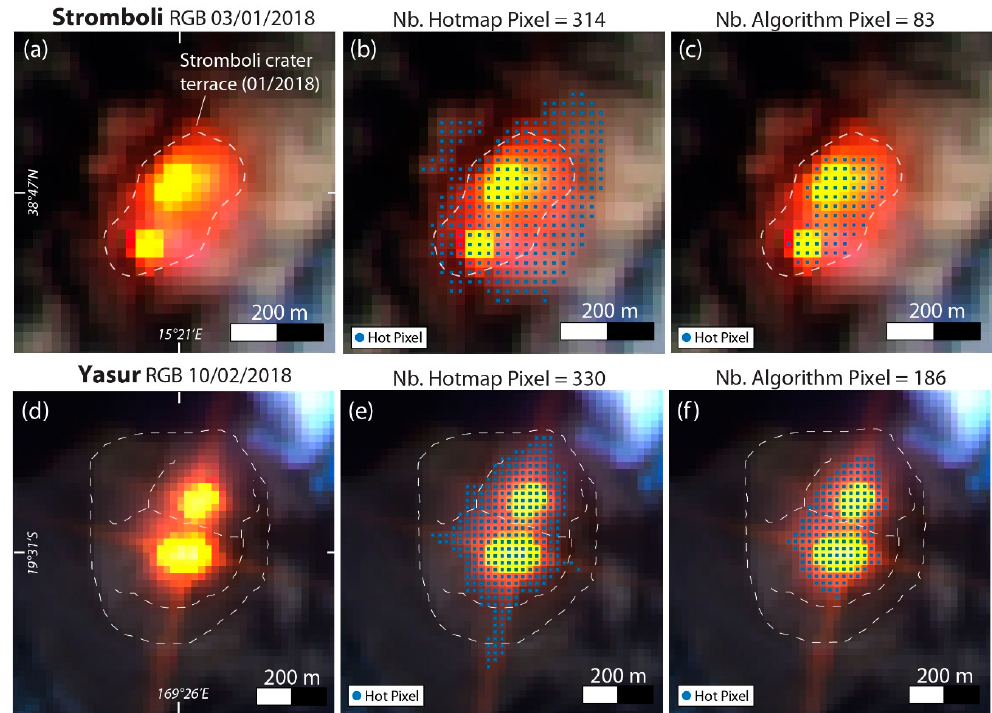
Figure 7. Application of the algorithm and comparison with Hotmap. ( a ) SENTINEL-2 MSI RGB (12-11-8a) image, over Stromboli crater summit area (roughly delimitated with a white dotted line by Google Earth analysis), 03/01/2018; ( b ) Application of Hotmap algorithm; ( c ) this work’s hot-spot algorithm; ( d ) SENTINEL-2 MSI RGB (12-11-8a) image, over summit crater of the Yasur pyroclastic cone, composed by the northern and southern vents (roughly delimitated with white dotted lines by Google Earth analysis), 10/02/2018; ( e ) application of Hotmap algorithm; ( f ) this work hot-spot algorithm. Blue dots mark the hot detected pixels by the respective algorithms.